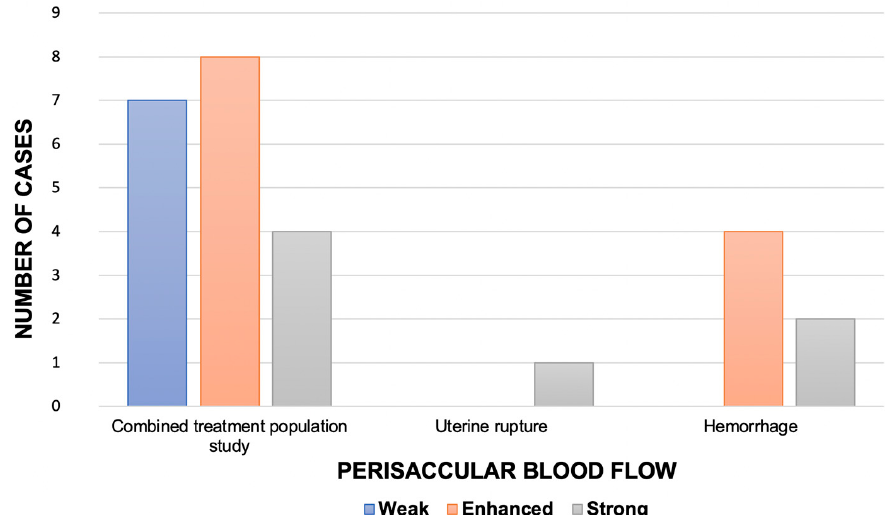
Figure 3. Perisaccular blood flow detected using color Doppler at first scan (expressed as number of cases, n ) in all the patients treated with the combined approach (methotrexate injection plus hysteroscopic resection) and according to the reported complication.